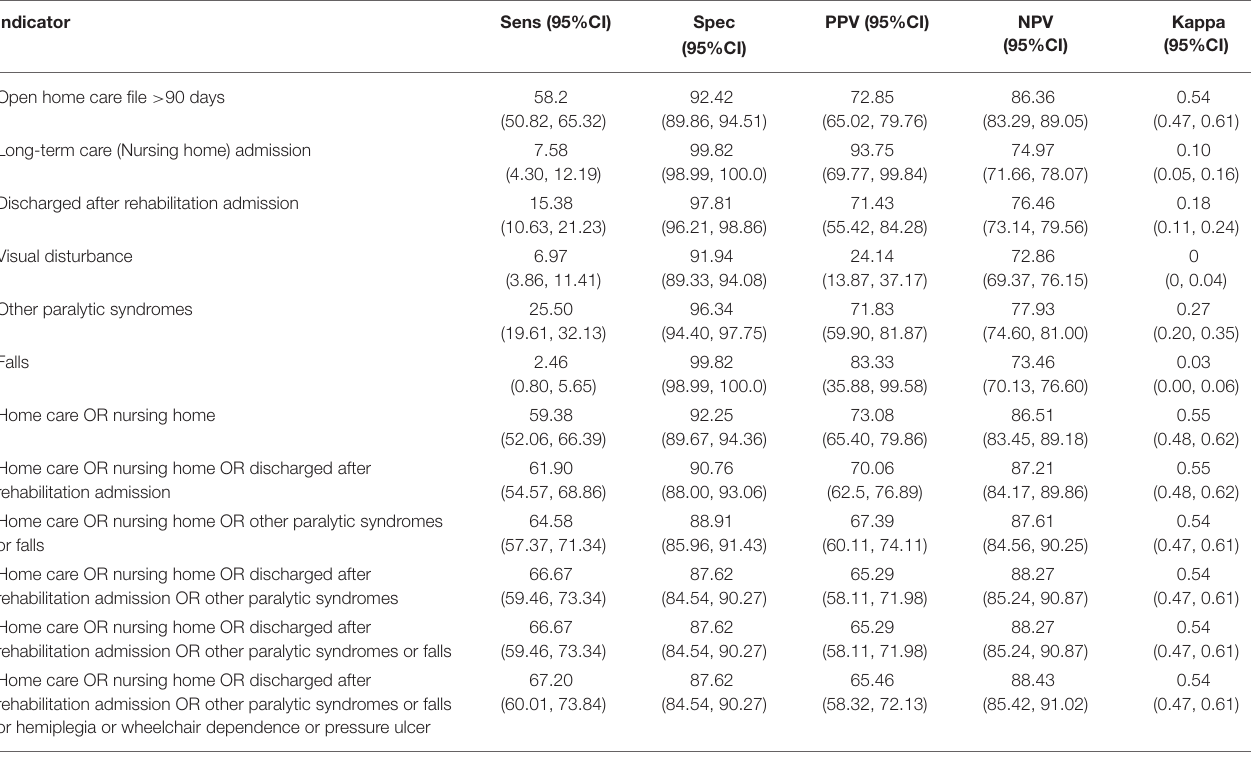
TABLE 2 | Performance of disability indicators for severe disability measured within 365 days after EDSS record, and within study window. Indicator